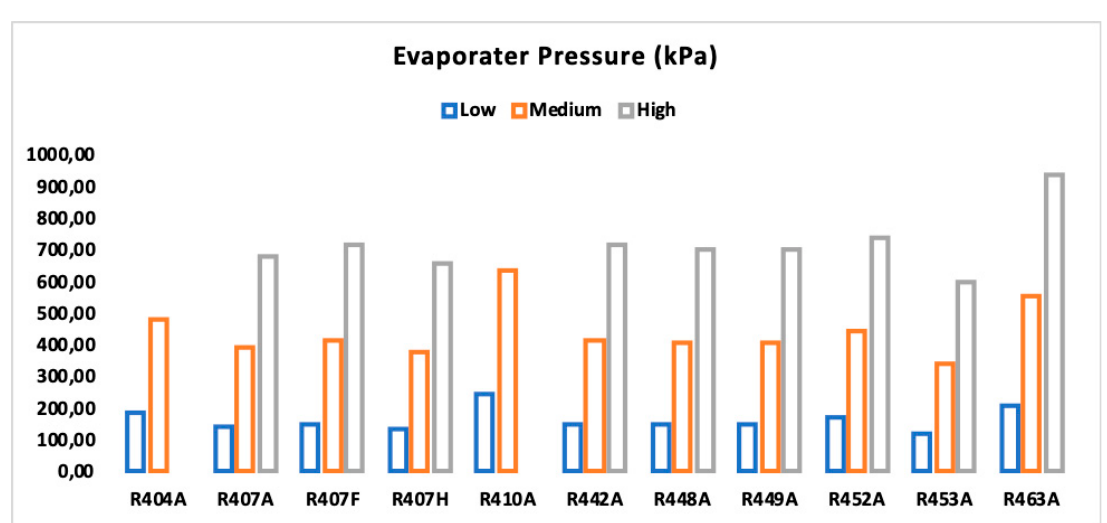
Figure 15. Evaporator pressure of all refrigerants.